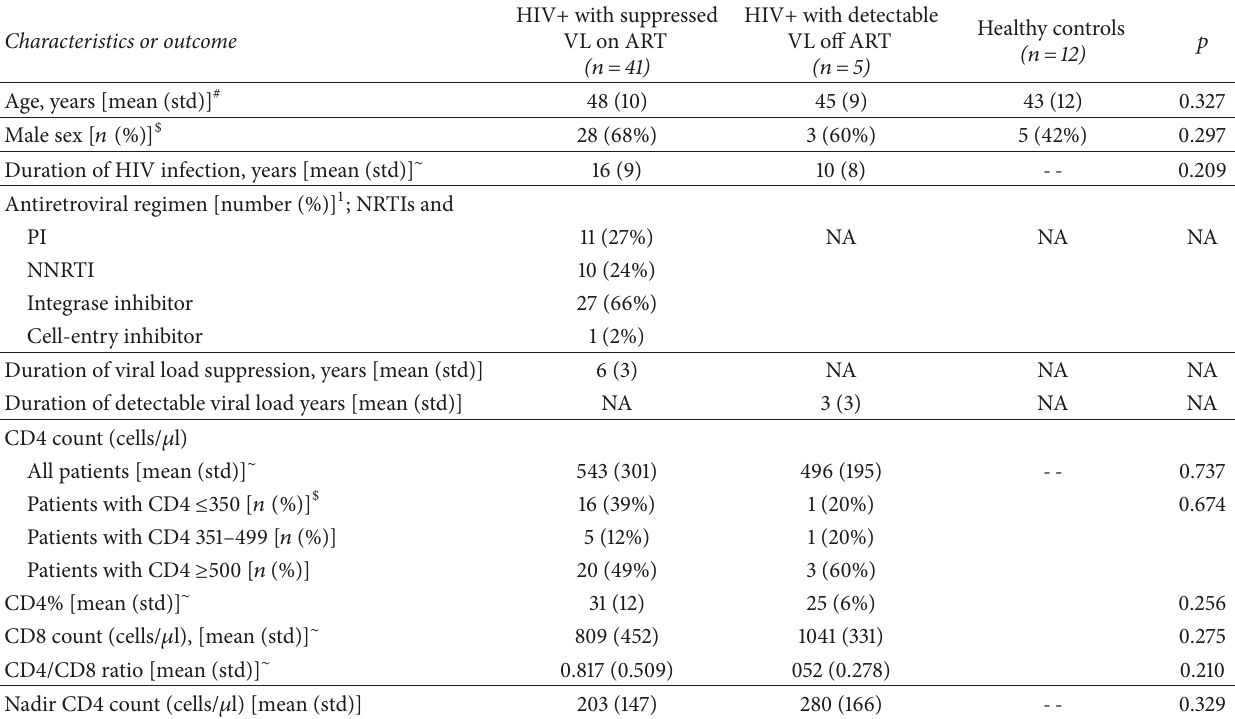
Table 1: Characteristics of study